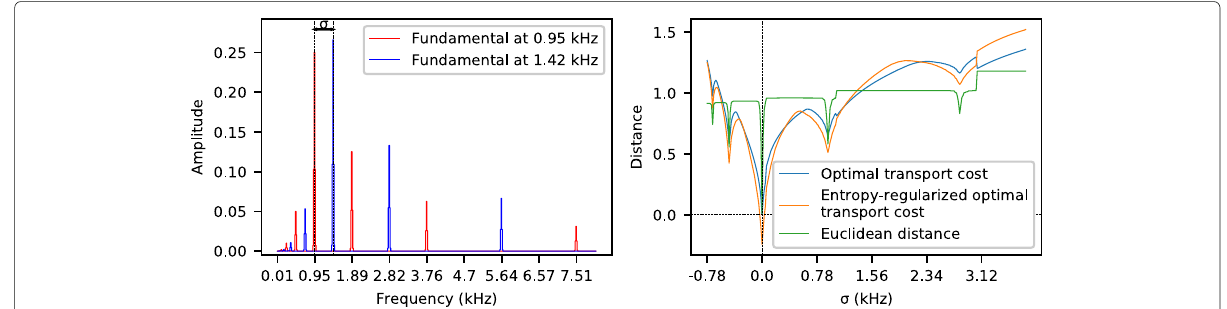
Fig. 1 Comparison of Euclidean distance and (regularized) optimal transport losses. Synthetic musical notes are generated by putting weight on a fundamental, and exponentially decreasing weights on its harmonics and sub-harmonics, and finally convoluting with a Gaussian. Left: examples of the spectrograms of two such notes. Right: (regularized) optimal transport loss and Euclidean distance from the note of fundamental 0.95 kHz (red line on the left plot) to the note of fundamental 0.95 kHz + σ , as functions of σ . The Euclidean distance varies sharply whereas the optimal transport loss captures more smoothly the change in the fundamental. The variations of the optimal transport loss and its regularized version are similar, although the regularized one can become